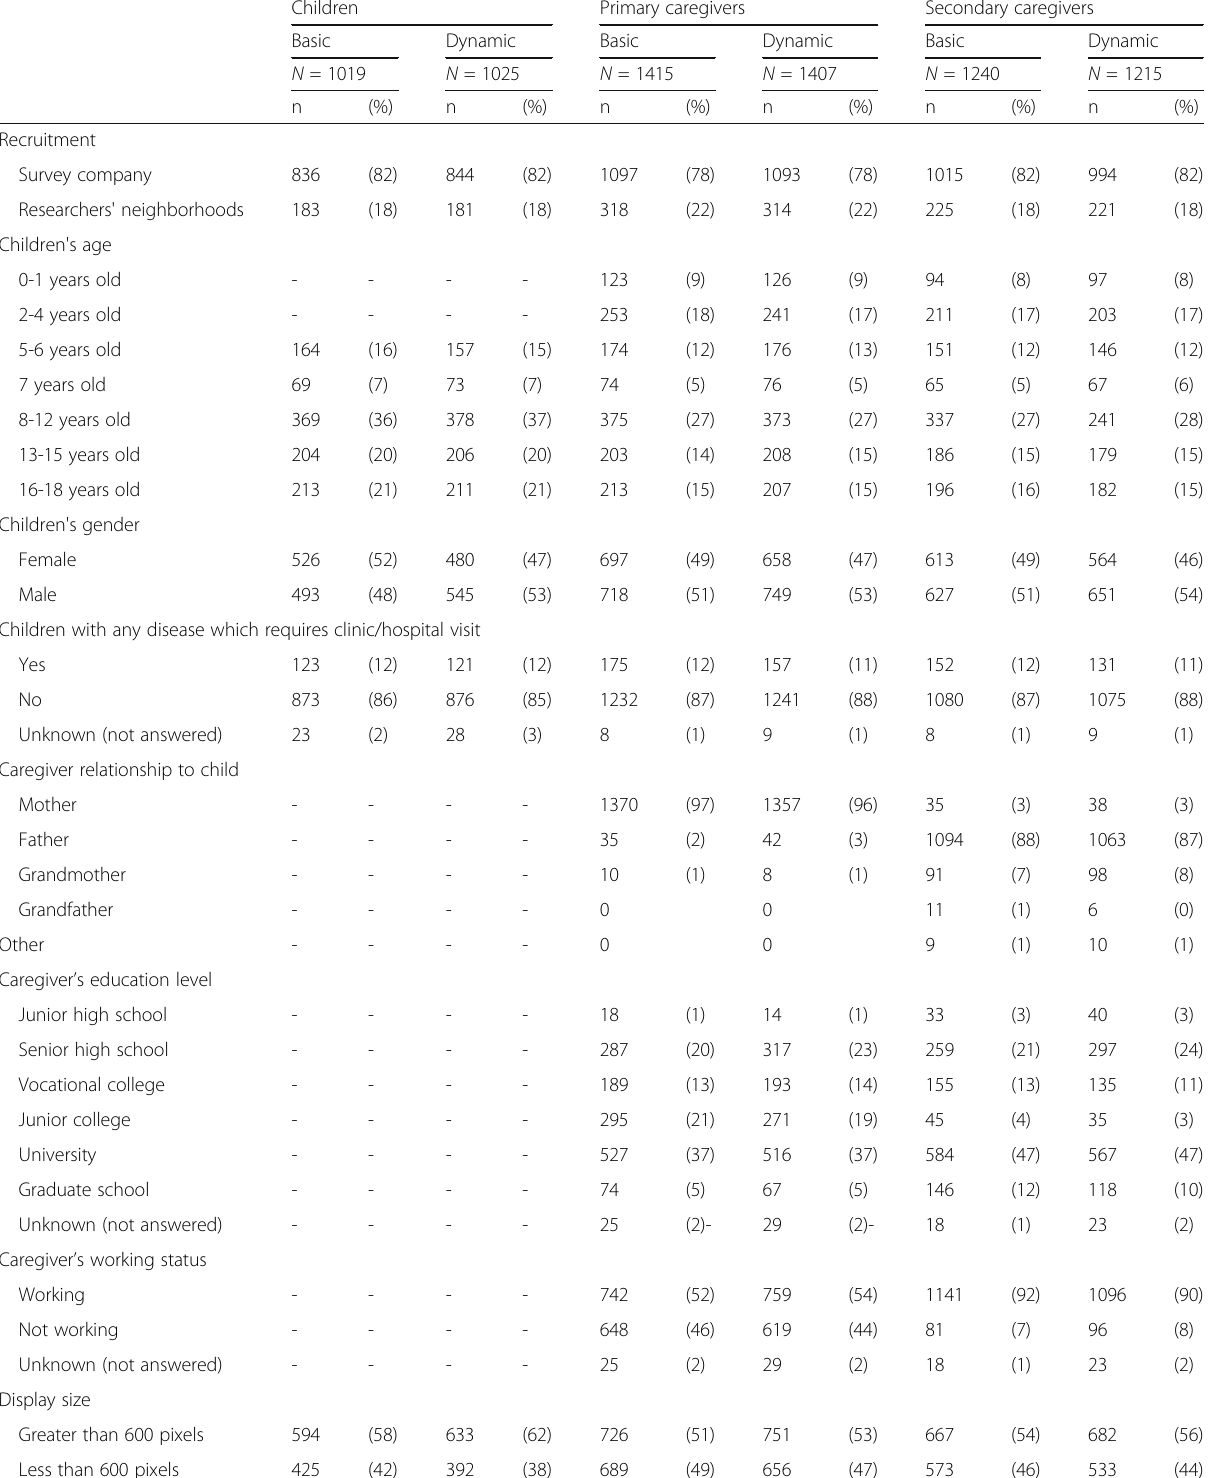
Table 1 Participant